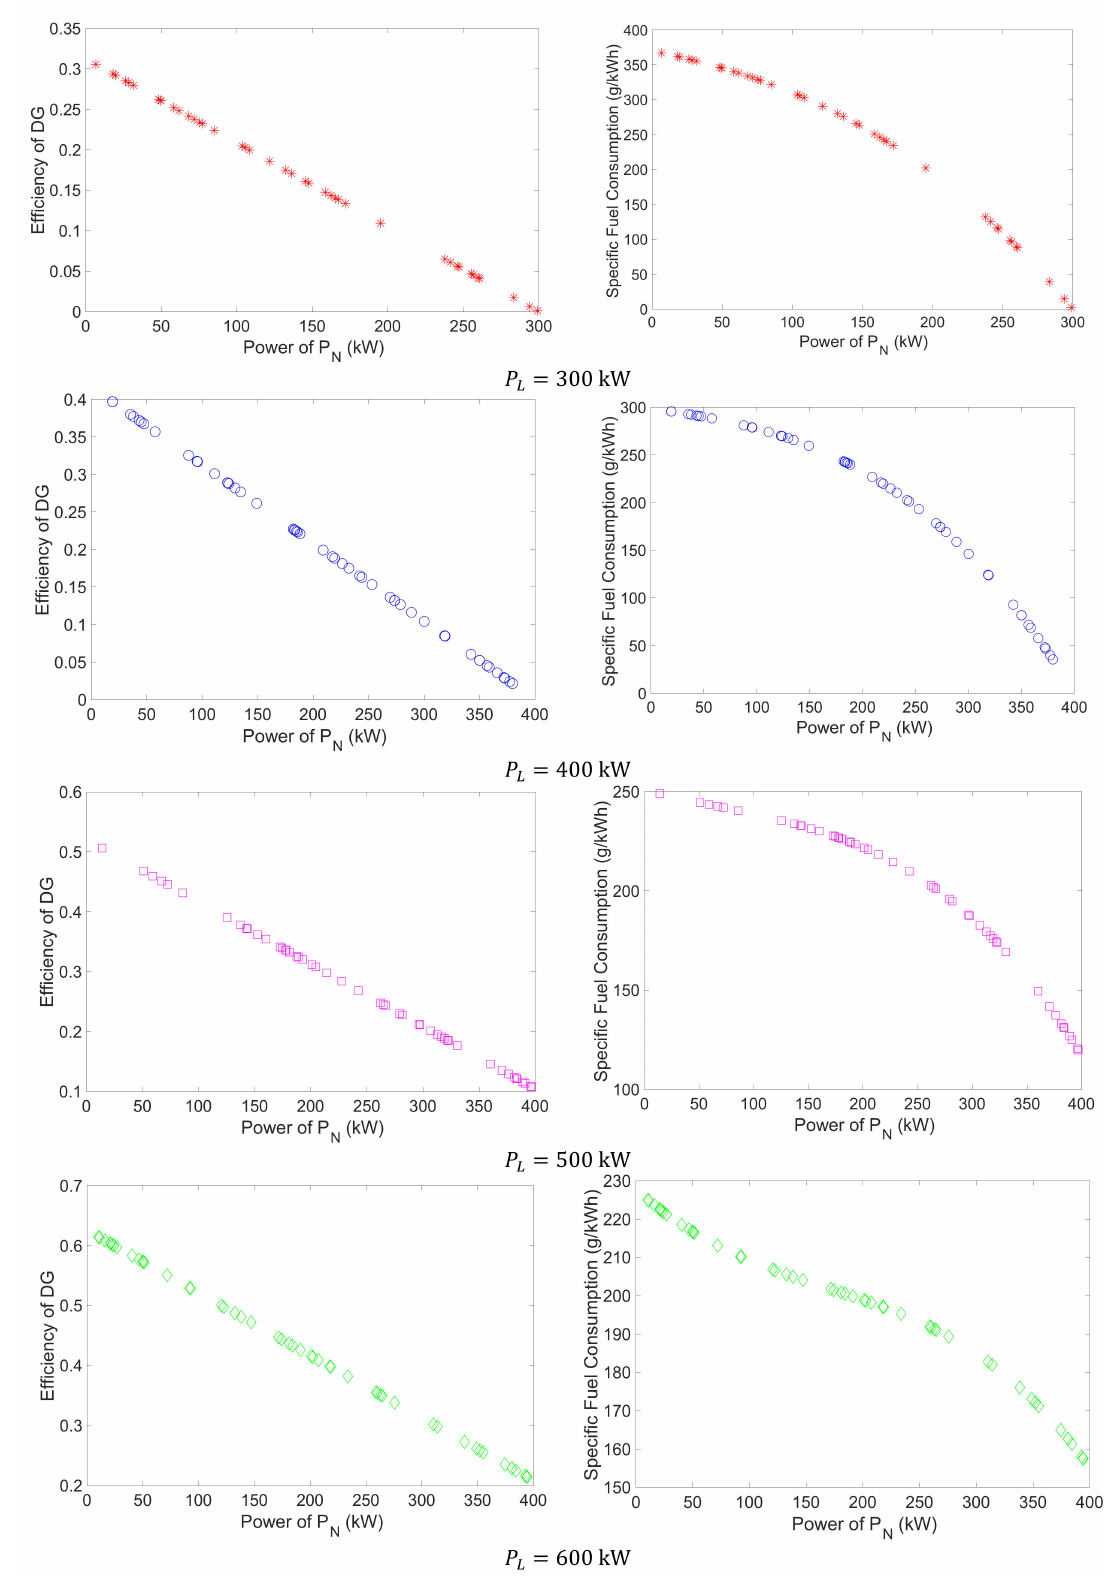
Figure 5. The spatial distribution of non-inferior solutions under di ff erent electrical